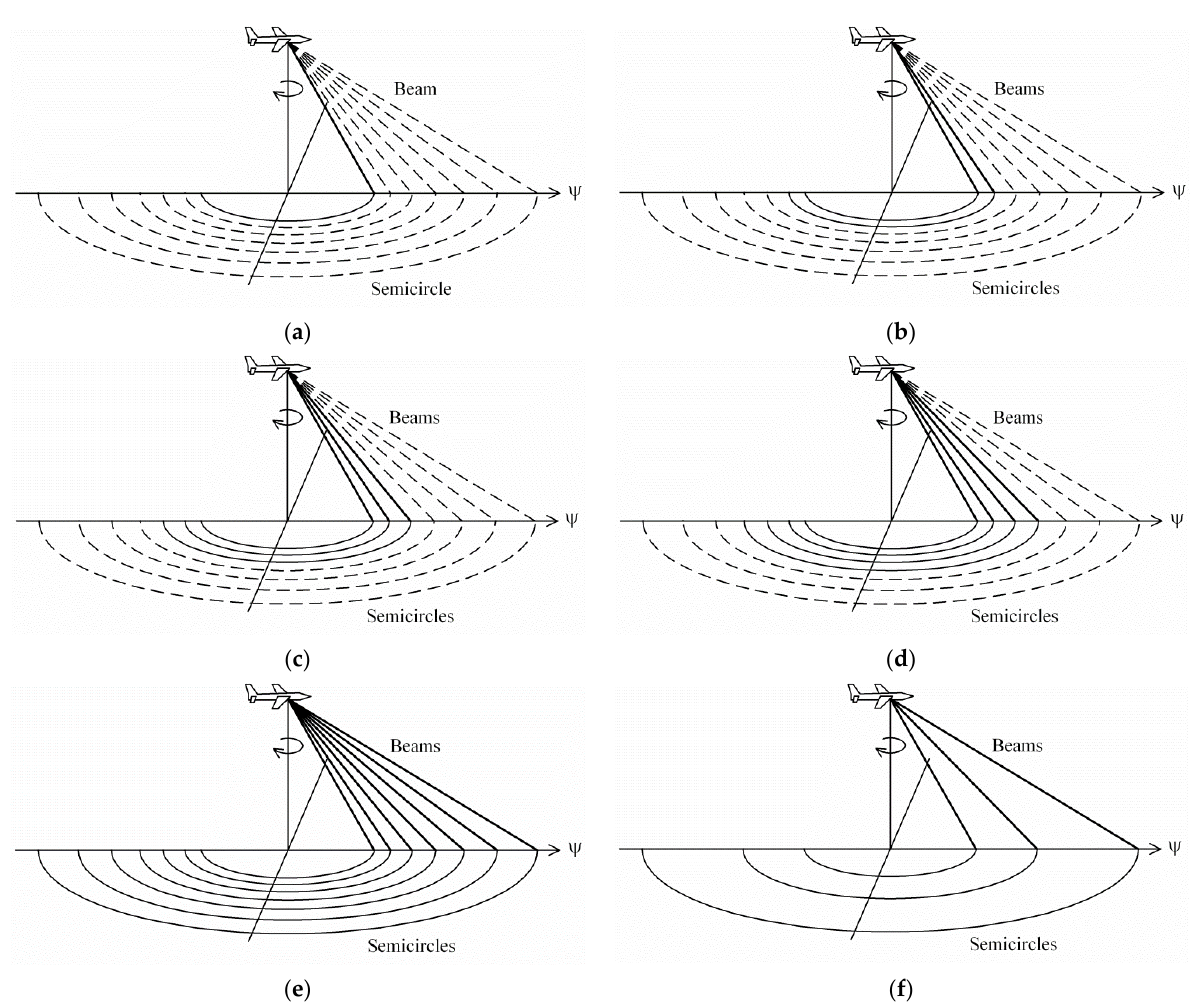
Figure 3. Schematic view of the incidence angle combinations’ geometries at the right-side semicircular NRCS sampling scheme in the given incidence angles’ range from 30° to 60°: ( a ) single incidence angle case; ( b ) case of 2 neighboring incidence angles; ( c ) case of 3 neighboring incidence angles; ( d ) case of 4 neighboring incidence angles; ( e ) case of 7 neighboring incidence angles; ( f ) particular case of 3 incidence angles of 30°, 45°, and 60°.